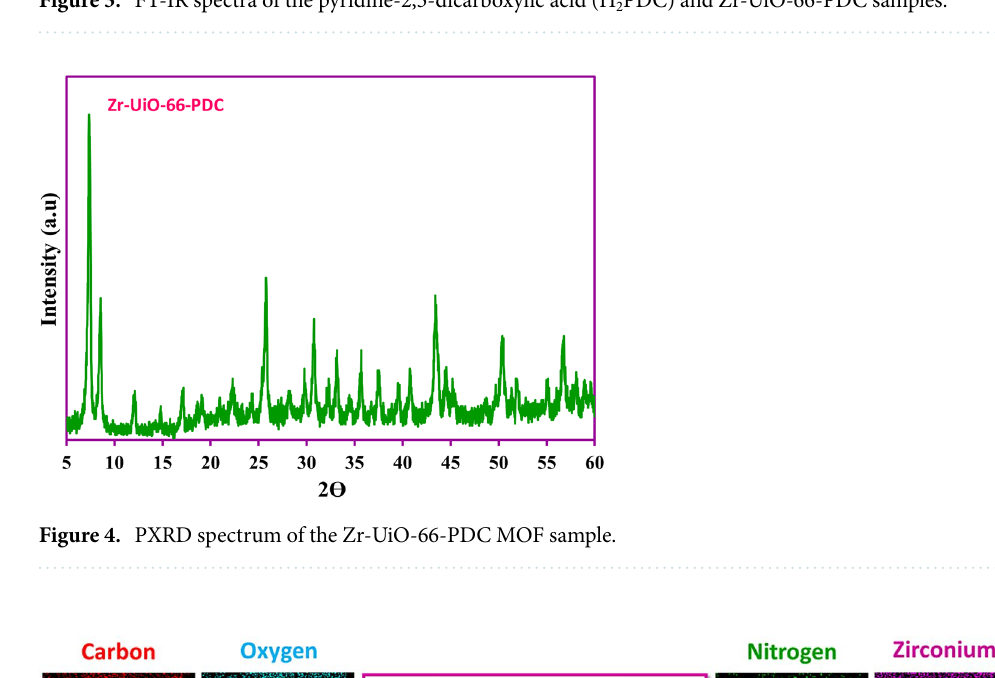
Figure 3. FT-IR spectra of the pyridine-2,5-dicarboxylic acid (H 2 PDC) and Zr-UiO-66-PDC samples.